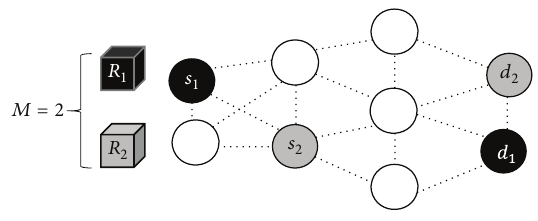
Figure 3: Illustration of transmitting two sessions in a 9-node network topology. The sizes of the two sessions are 𝑅 1 an 𝑅 2 , respectively, and the pairs of their source and destination nodes are , 𝑑 ) and (𝑠 , 𝑑 ) , (𝑠 1 1 2 2